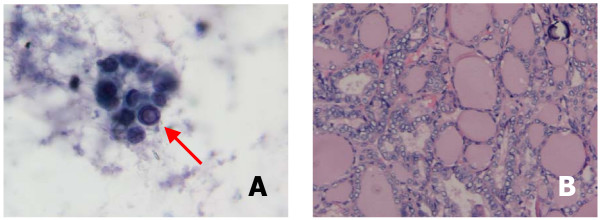
a. Cytology consistent with papillary thyroid cancer including nuclear size variation, microfollicle cellular arrangement and an intranuclear pseudo-inclusion (arrow). Papanicolaou stain at 400× magnification. b. Final histology showed a papillary carcinoma, follicular variant. There are characteristic nuclear features including ground glass nuclei, inconspicuous nucleoli, thickened nuclear membranes, nuclear pseudoinclusions, and nuclear grooves. This slide also shows a psammoma body. Hematoxylin & Eosin stain at 200× magnification.